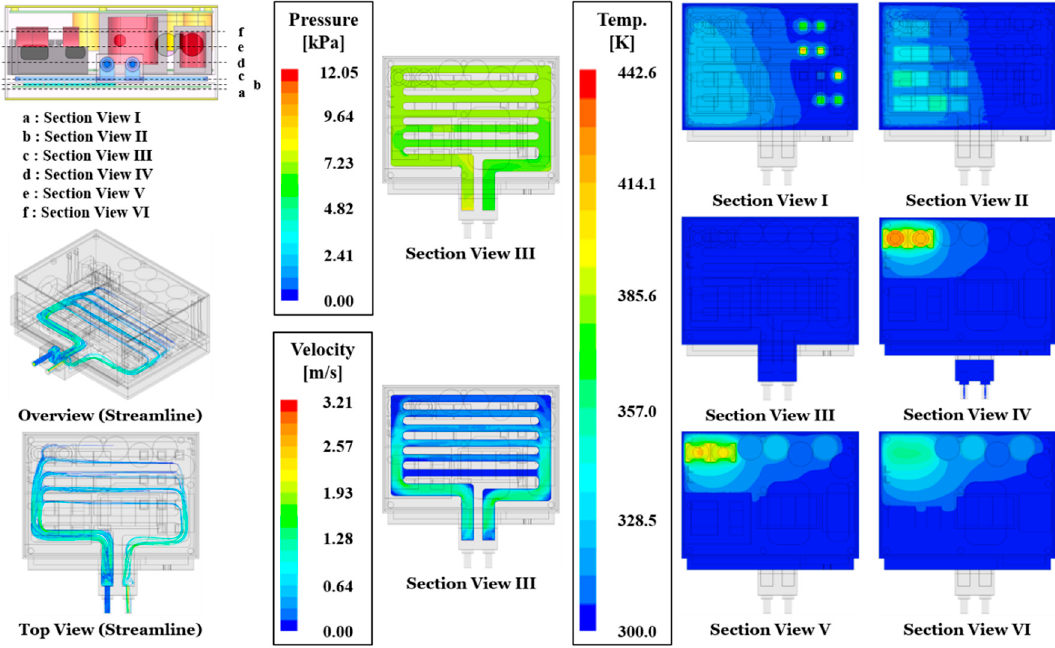
Figure 12. Streamline, pressure, velocity, and temperature distribution in the integrated module for a cooling water flow rate of 6 LPM over a time period of 4000 s in Operating Mode 3.